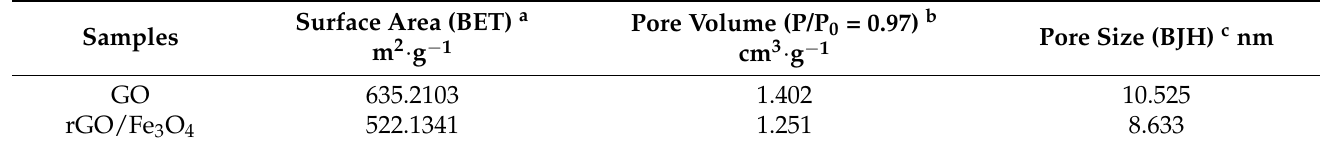
Table 1. BET computation outcomes for GO and rGO/Fe 3 O 4 .